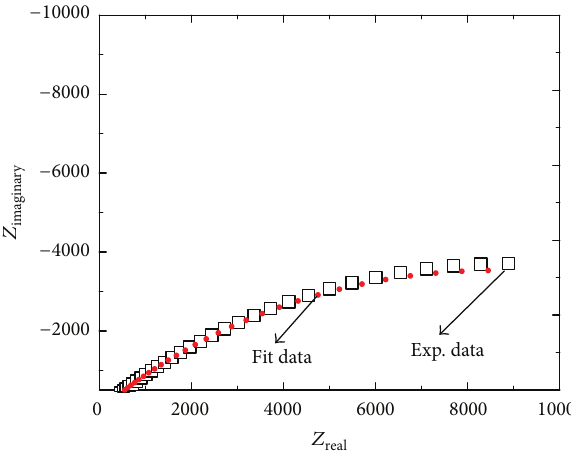
Figure 5: Nyquist diagram for carbon steel in 1M HCl containing different concentrations of inhibitors.